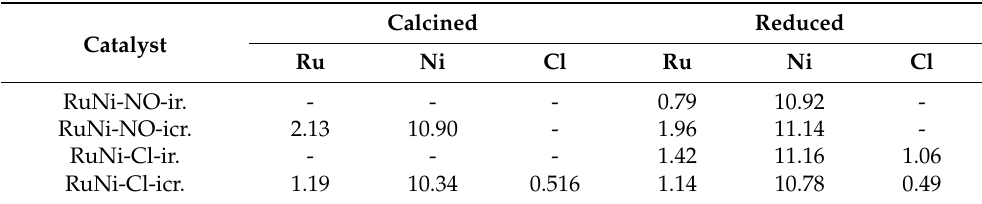
Table 3. XRF data for all RuNi on γ -Al 2 O 3 catalysts after calcination (ic), and reduction (icr)/direct reduction